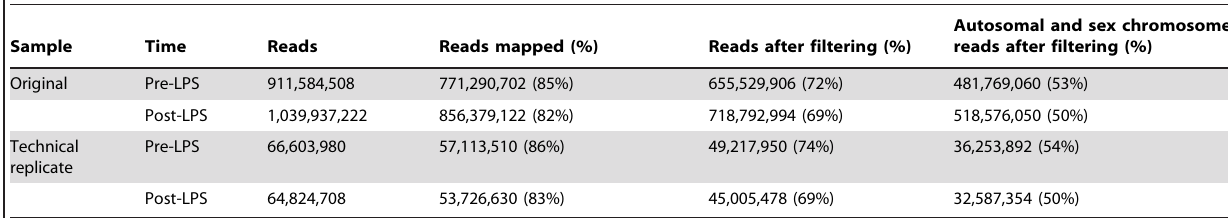
Table 1. Mapping